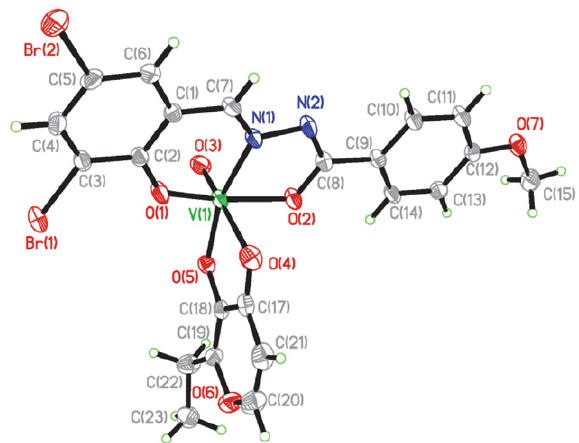
Fig. 2. An ORTEP diagram of complex 2 with atom labeling scheme and 30% probability thermal ellipsoids for all non-hydrogen atoms.